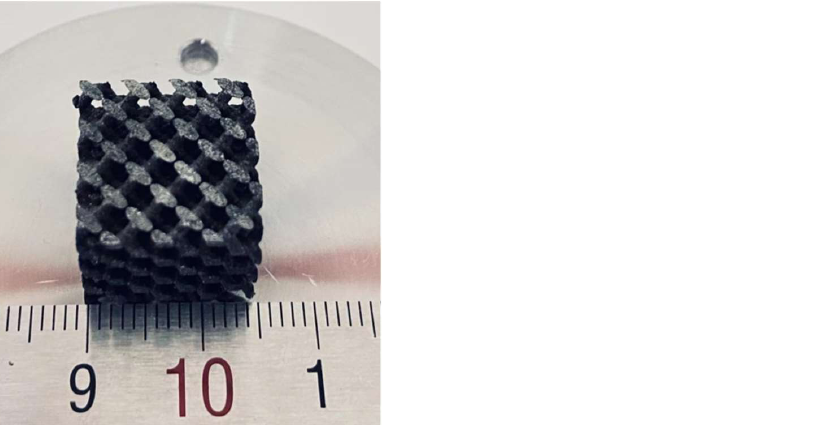
Figure 7. Laser additively manufactured Fe/ZnS composite scaffold with porous